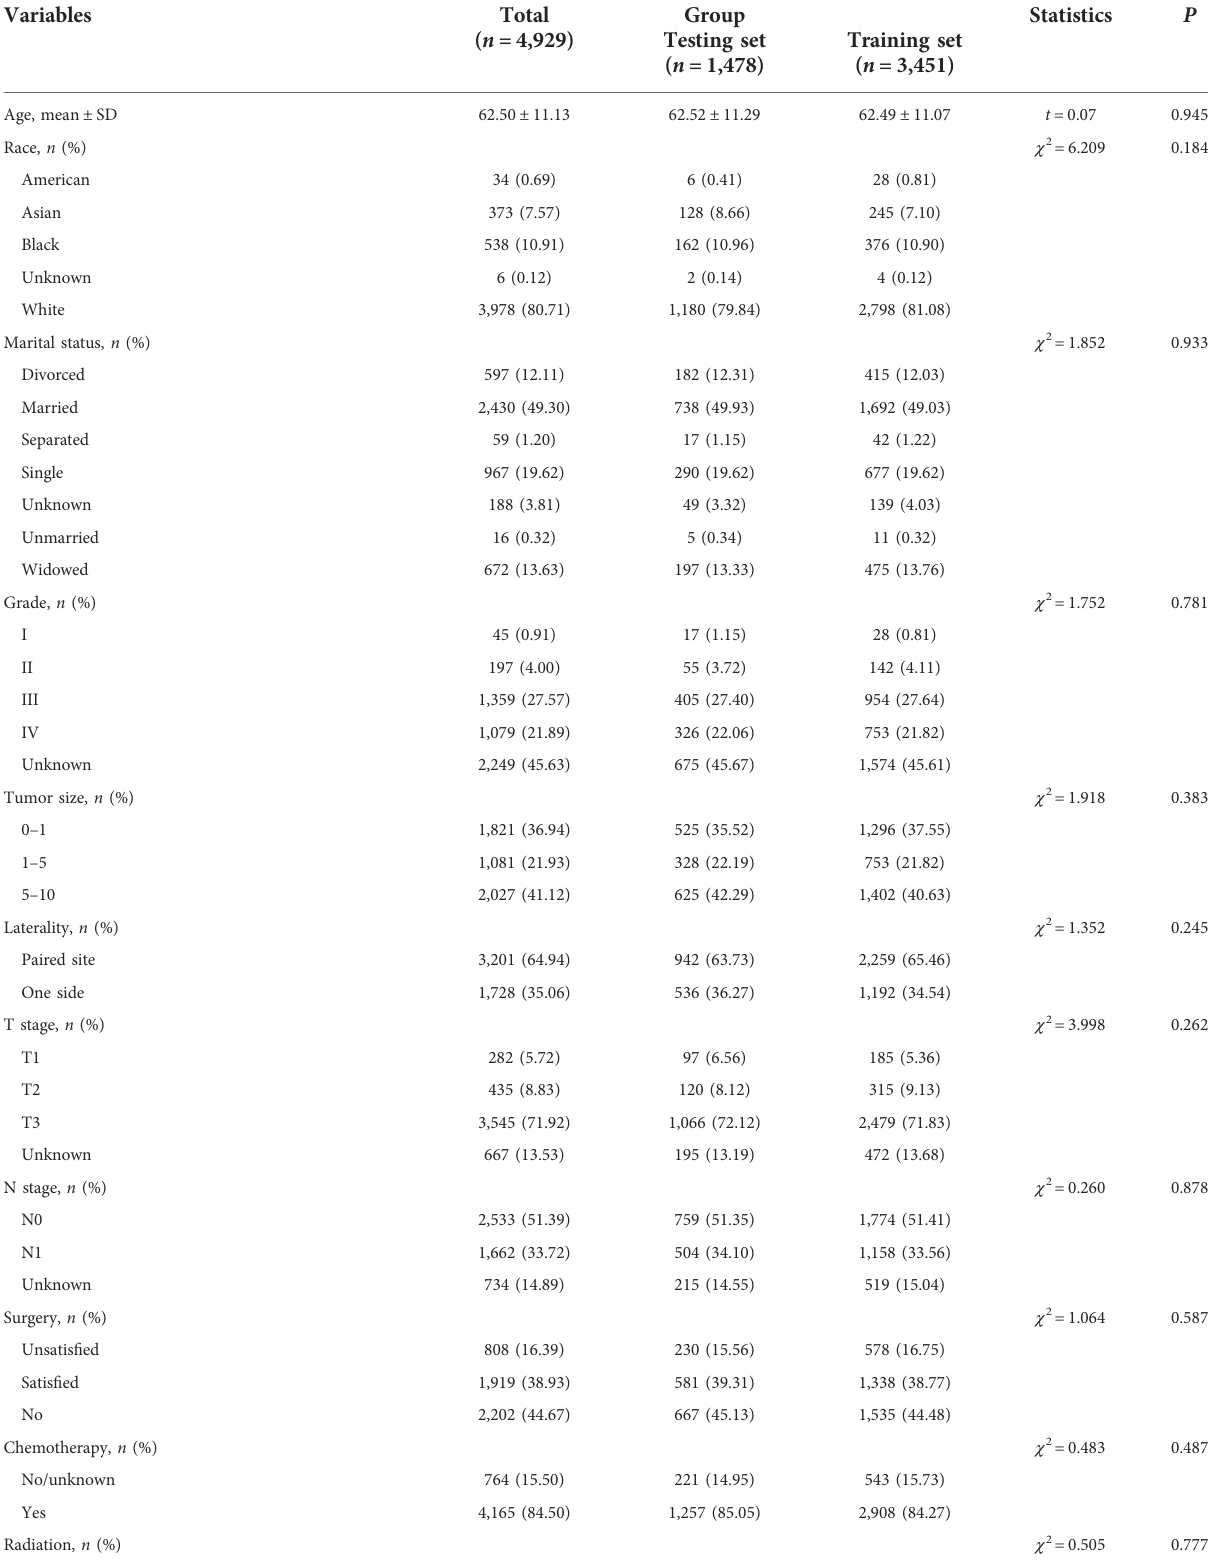
TABLE 2 Equilibrium analysis of the data in the training set and the testing